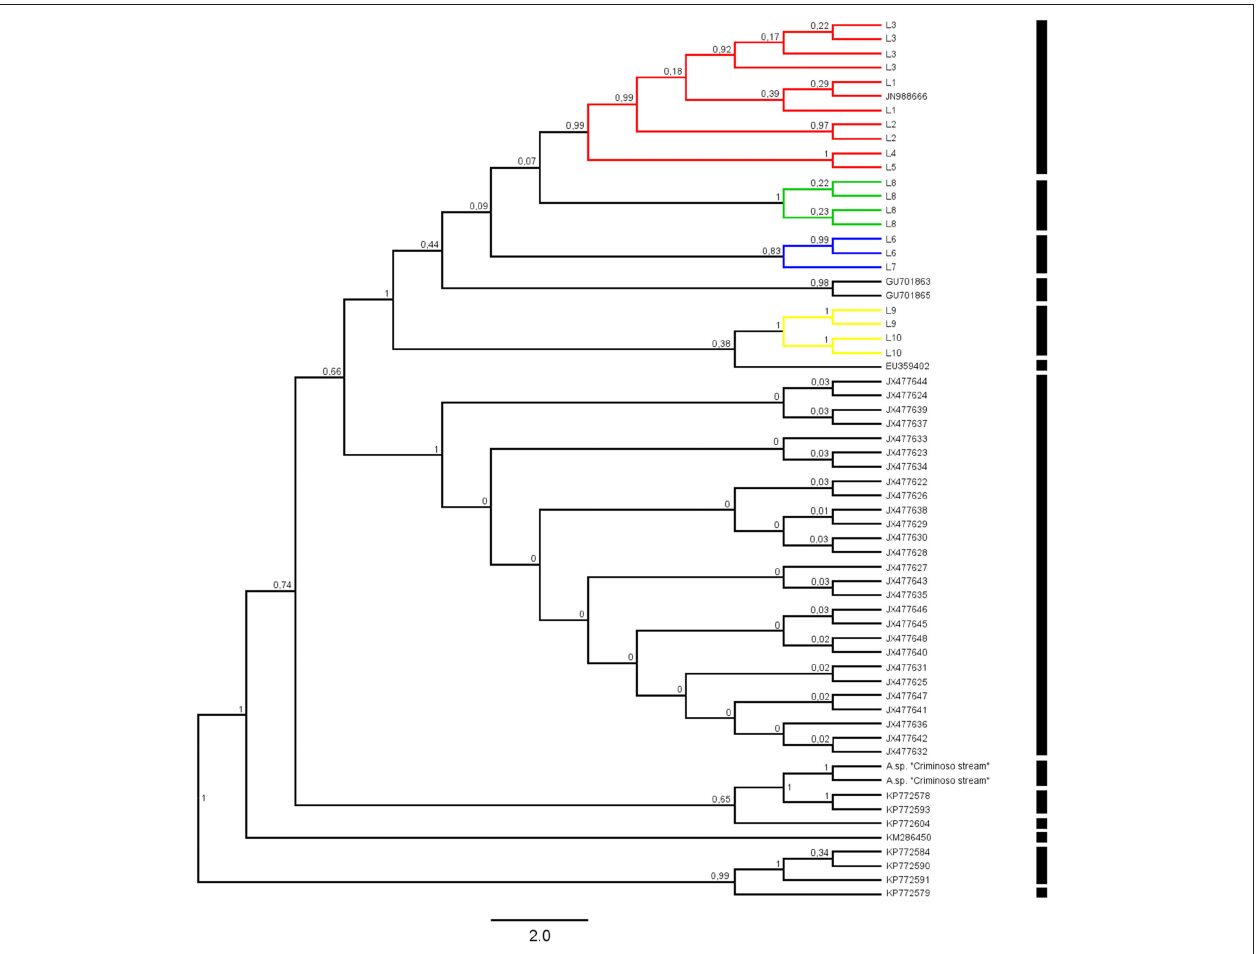
FIGURE 3 | Bayesian consensus tree for the Ancistrus species of the Paraná River basin produced in BEAST2 2.4.0 and obtained from 10 million generations. Posterior probabilities are shown above the branches. Each color represents one of the five evolutionary lineages recovered. The results of the GMYC method using the Yule model of species delimitation are shown as black bars to the right of the phylogeny. Species access numbers are specified in the supplementary material (Supplementary File 1). Codes: L1, Mourão River; L2, 19 Stream; L3, Keller River; L4, Patos River; L5, São João River; L6, São Francisco Verdadeiro River; L7, Arroyo Iguaçu; L8, Ancistrus cirrhosus ; L9, Ocoí River; L10, São Francisco Falso